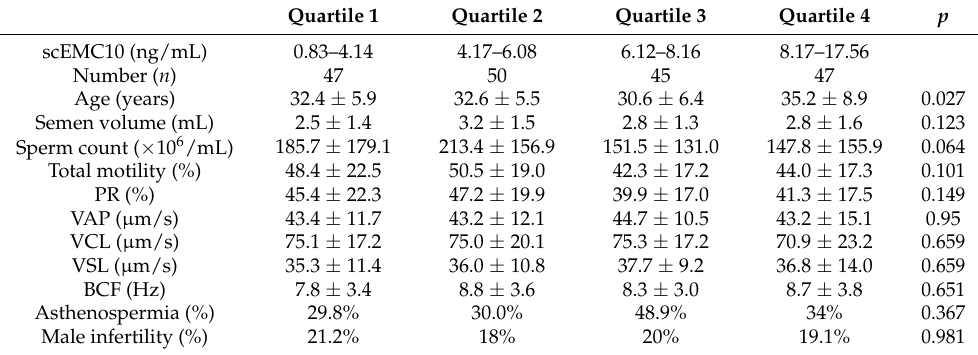
Table 2. Characteristic parameters of sperm samples grouped into seminal plasma scEMC10